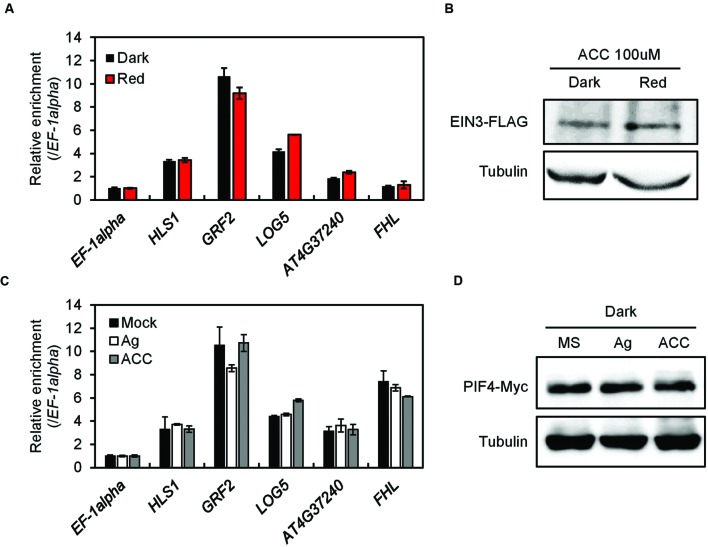
Phytochrome-interacting factors and EIN3 bind independently to their shared target promoters. (A,C) ChIP assay for EIN3 and PIF4 binding to shared target promoters (HLS1, GRF2, LOG5, and AT4G37240) under dark and red light conditions (A) or under darkness untreated or treated with 20 μM AgNO3 or 10 μM ACC (C). Fold enrichment was calculated by normalizing the results with respect to an input control and a control region, EF-1-alpha (SD, n = 3 biological replicates). FHL was used as a PIF-specific target gene. (B,D) EIN3-FLAG and PIF4-Myc protein levels were measured under the indicated conditions. Tubulin was used as a loading control.